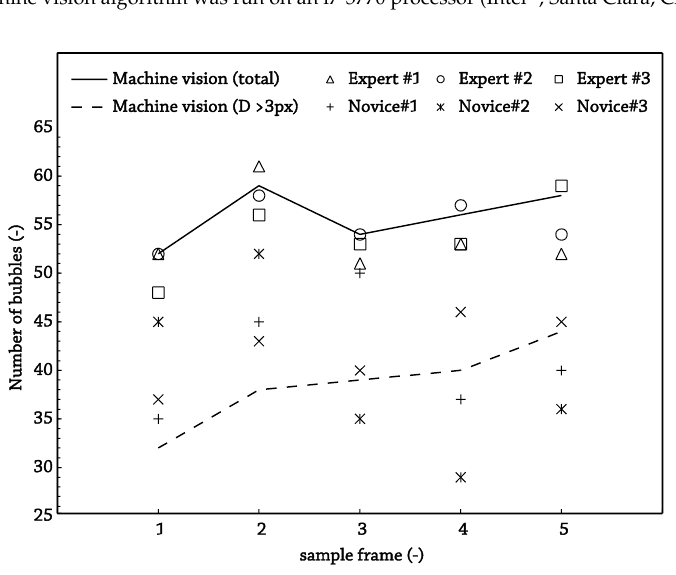
Figure 12. Detected bubbles by frame of the validation sample.